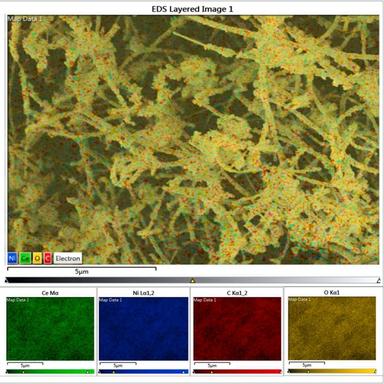
Elemental mapping analyses of NiCeO2@f-MWCNT/EDA.